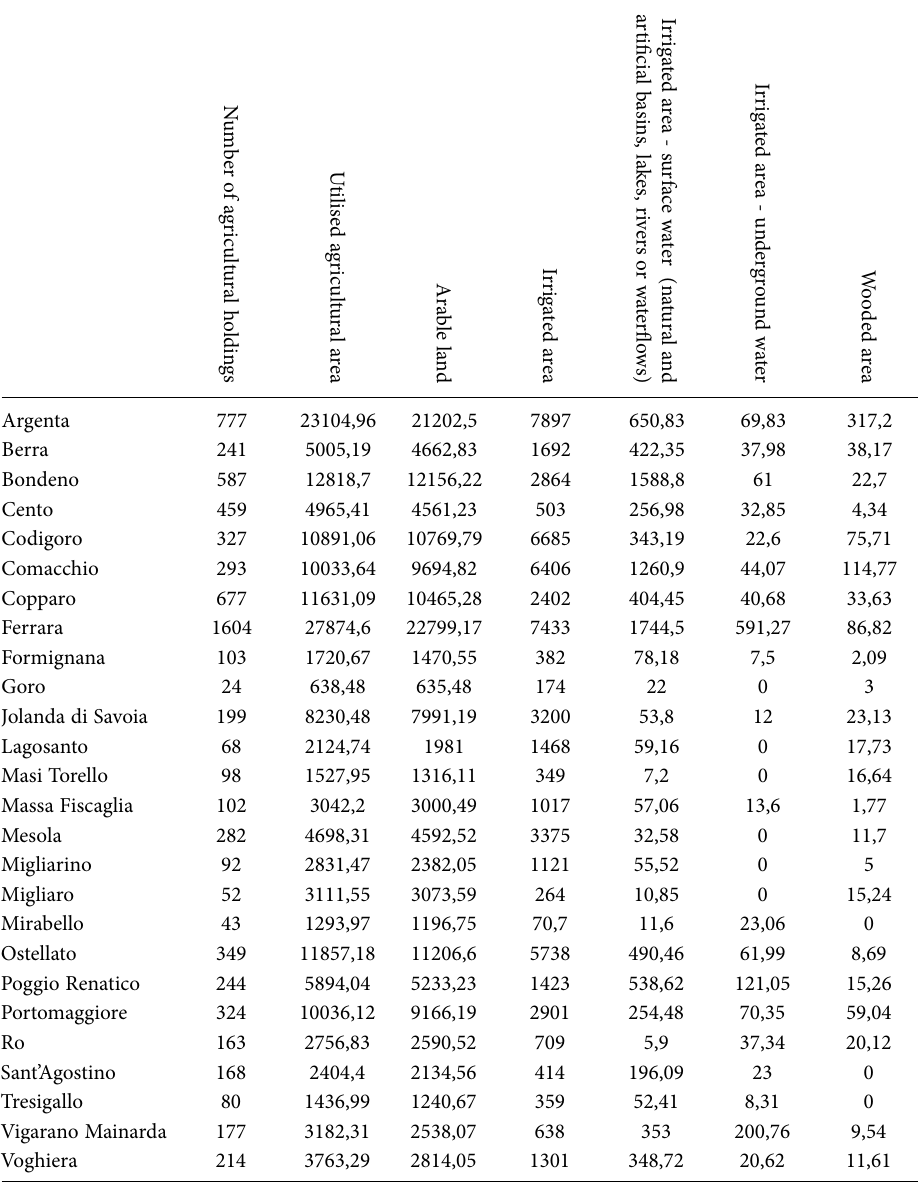
Table A1. Ecosystem services